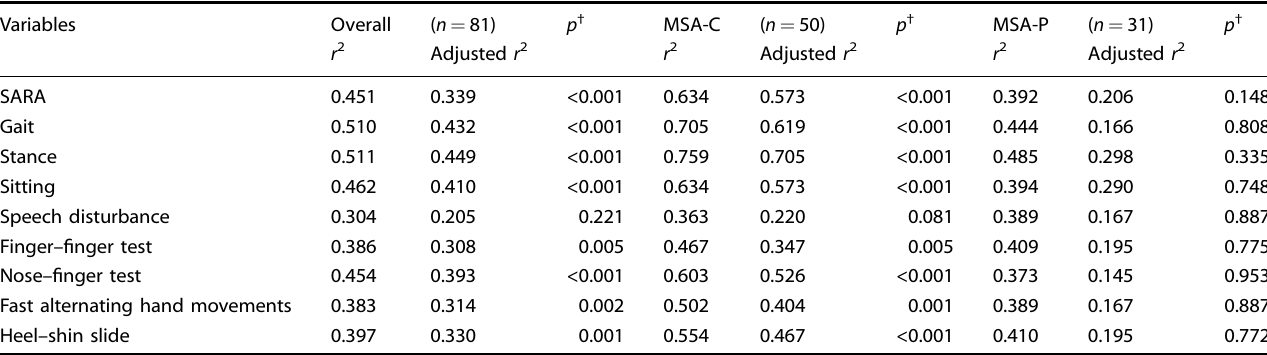
Table 4. Relationship between HCBs and severity of ataxia as assessed by score of sums and each item of SARA.